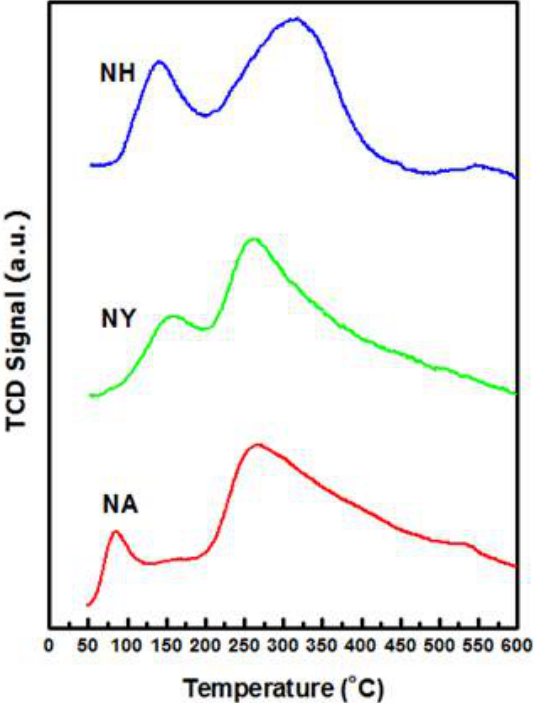
Figure 6. CO 2 -TPD for Ni supported on alumina (NA), Ni supported on Y-zeolite (NY), and Ni supported on H-ZSM-5 (NH) fresh catalysts.